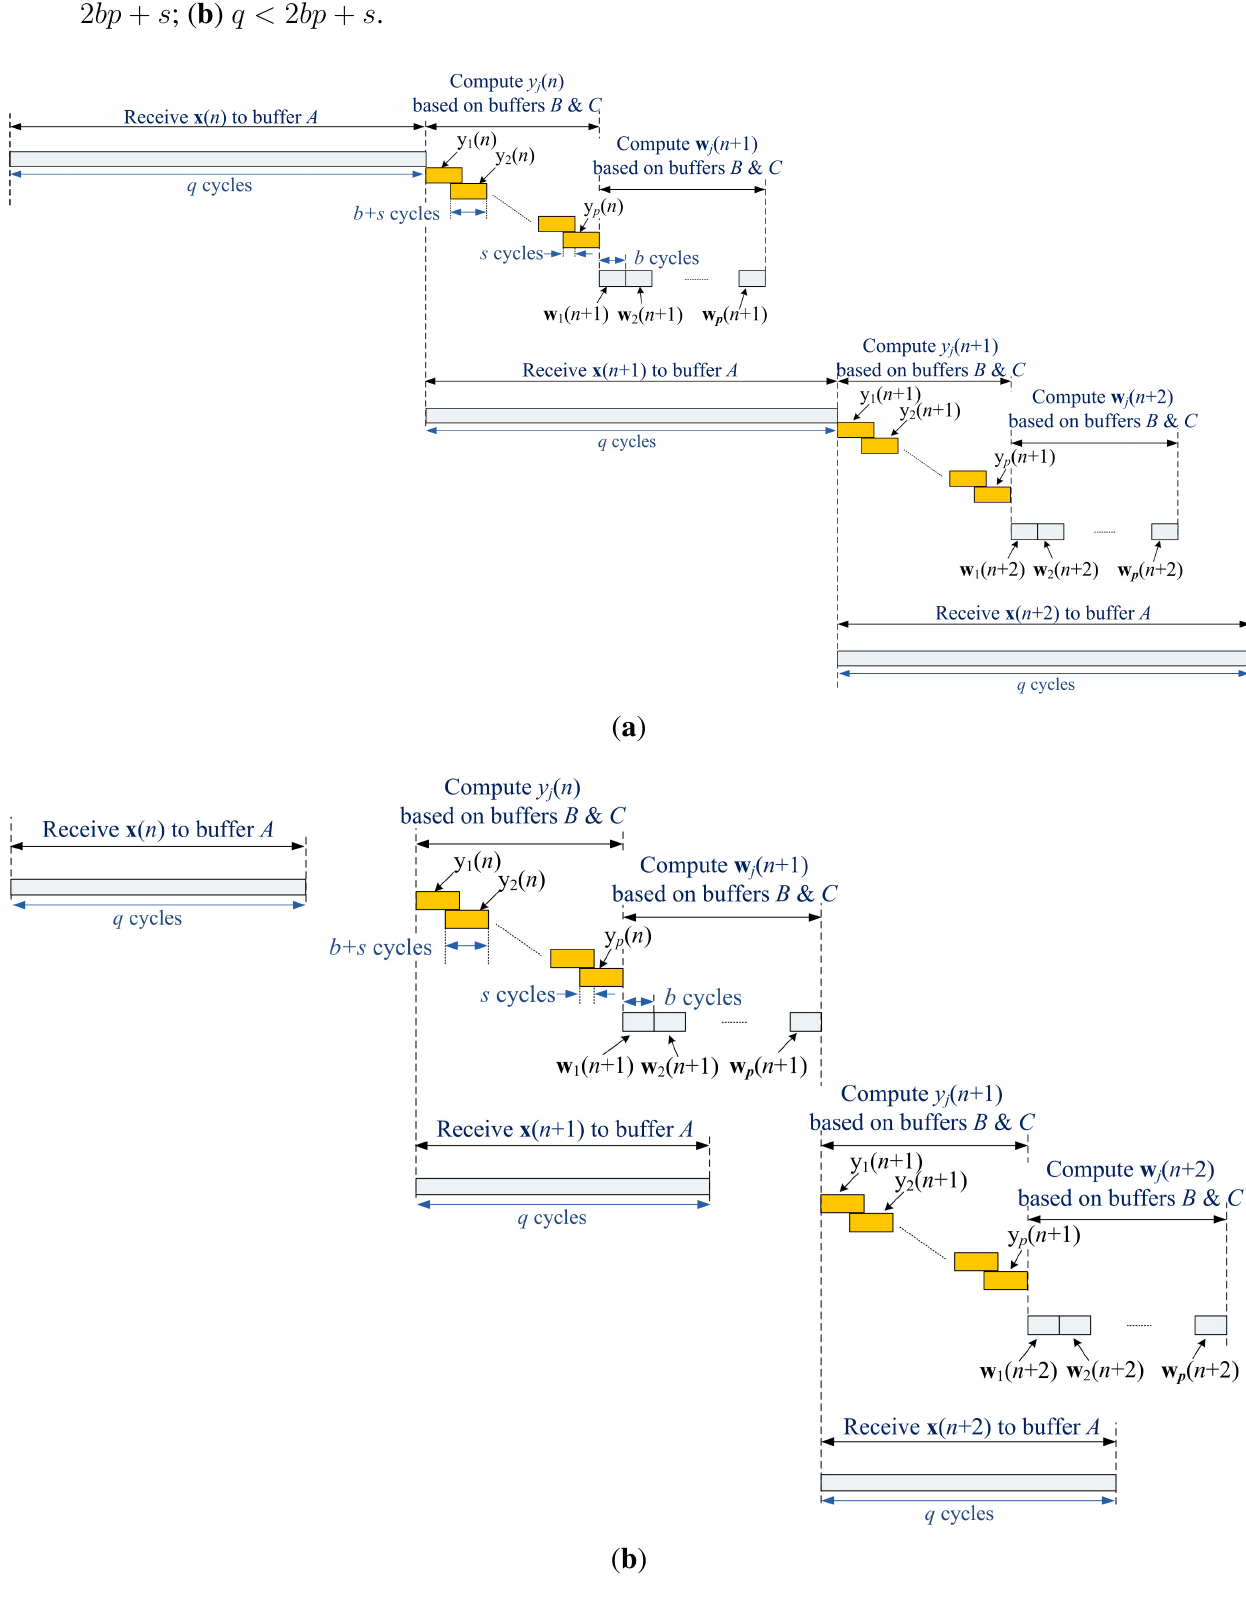
Figure 14. The timing diagram for the operations of the proposed architecture: ( a ) q > 2 bp + s ; ( b ) q < 2 bp + s